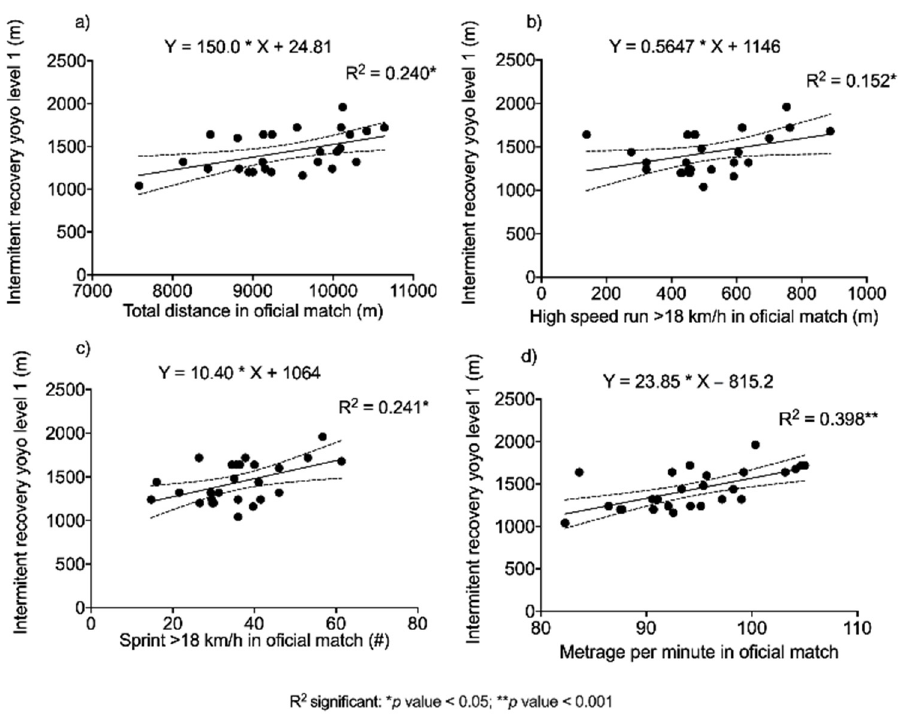
Figure 7. Simple linear regressions between aerobic capacity and official match performance. ( a ) Total distance; ( b ) High speed run; ( c ) Number sprint; ( d ) Metrage per minute.